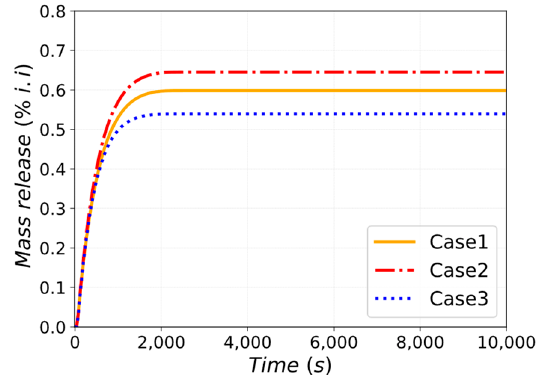
Figure 17. Direct unfiltered release of ACP (%i.i).